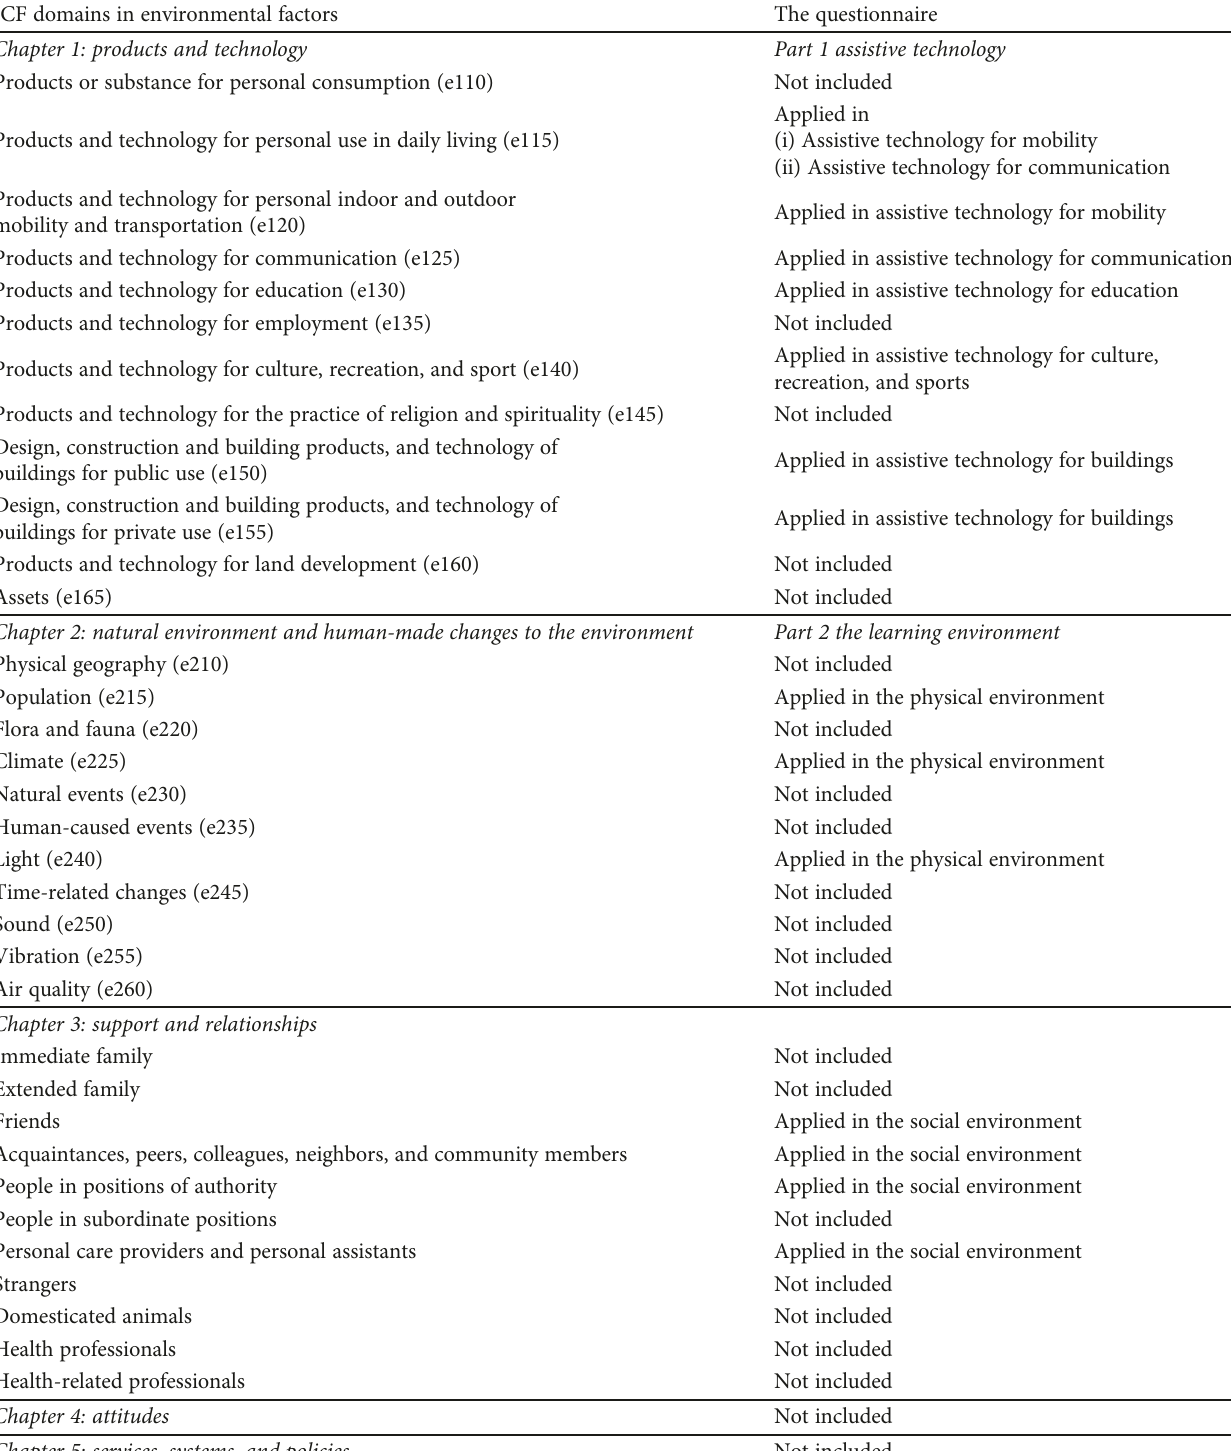
Table 1: Applying ICF to the questionnaire on facilitators and barriers of assistive technology and the learning environment. ICF domains in environmental